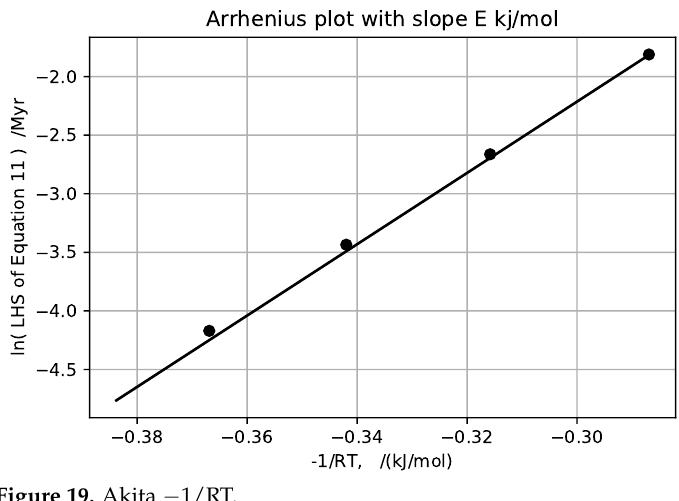
Figure 19. Akita − 1/RT.